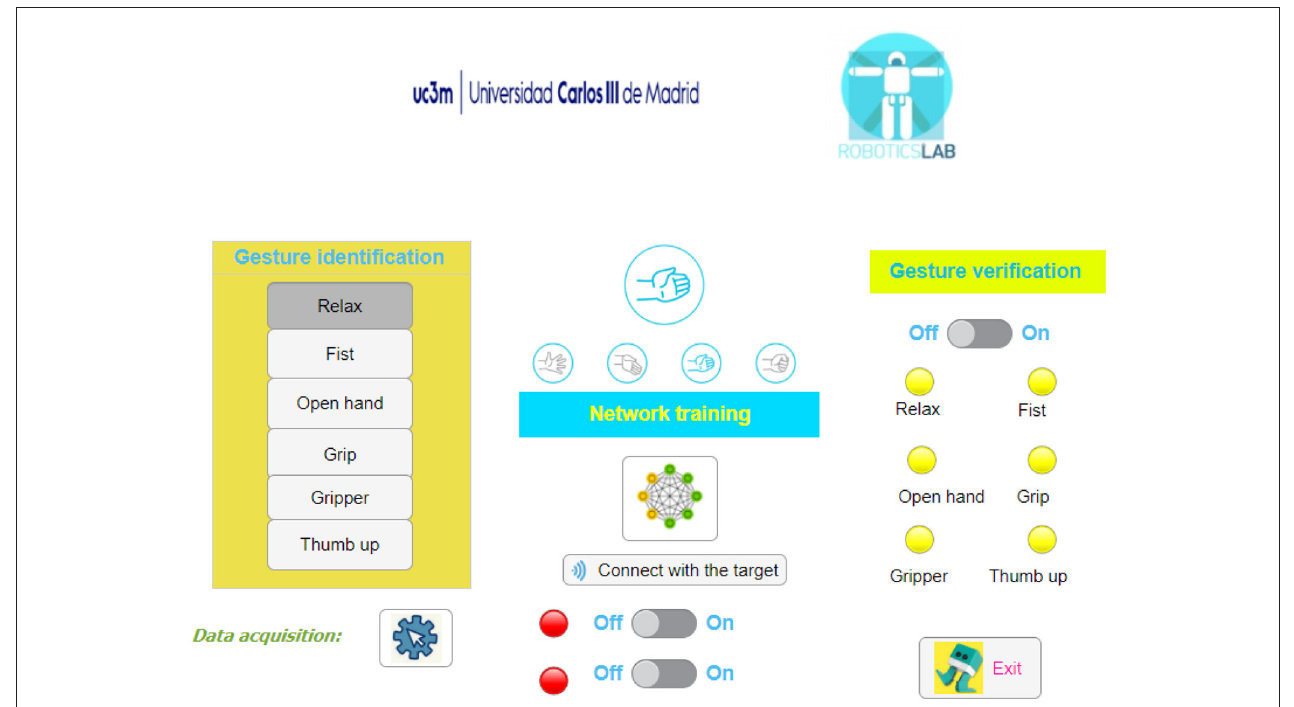
FIGURE 5 | User interface for the developed